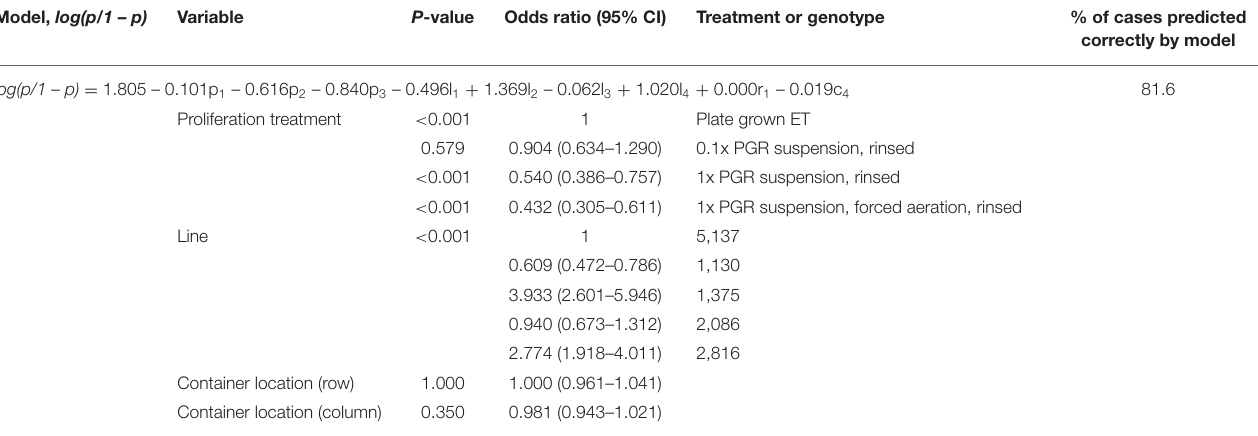
TABLE 2 | Logistic regression model used for analyzing the effect of proliferation and maturation treatments in Experiment IV on transplanted embryo survival. Model, log(p/1 –